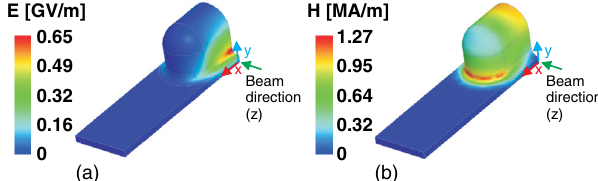
FIG. 4. Schematic of the experimental FACET section.